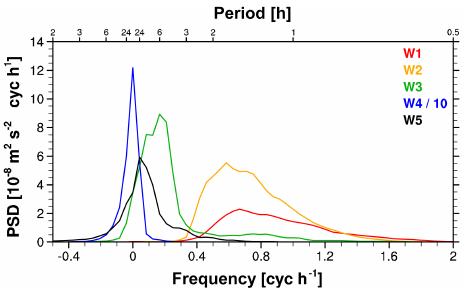
Figure 8. Frequency power spectra of w (cid:48) at z = 8km for W1 (red), W2 (yellow), W3 (green), W4 (blue), and W5 (black). The posi- tive and negative frequencies indicate eastward and westward prop- agation of the waves, respectively. For W4, the power spectrum is divided by 10.